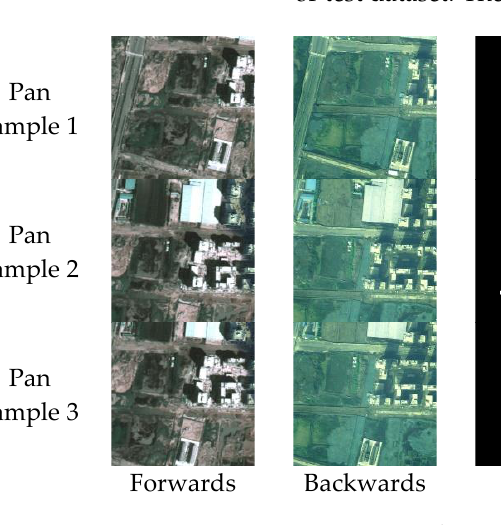
Figure 3. Newly added construction land labeling results.